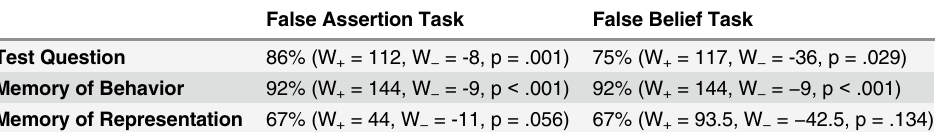
Table 1. Percentage of Successes (Comparison to Chance by One-sample WSRT) on the Test Ques- tion, Memory of Behaviour, and Memory of Representation in the False Assertion Task and in the False Belief Task of Study